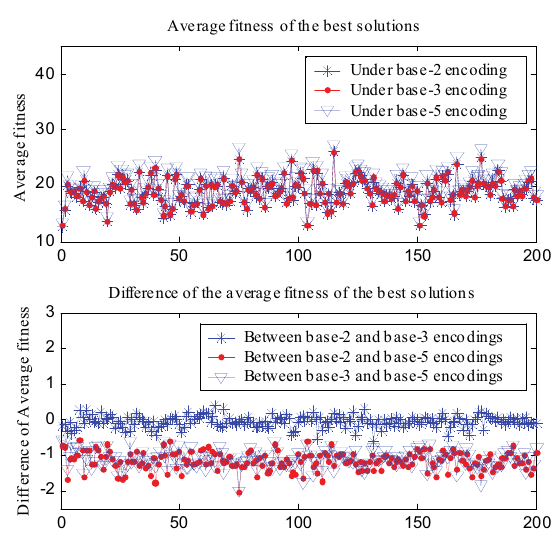
Fig. 5. The average fitness of the best solutions found in the 20 rounds of calculation for the fitness functions ∑ 22 ings. The GA with the base-5 encoding significantly outperform the other